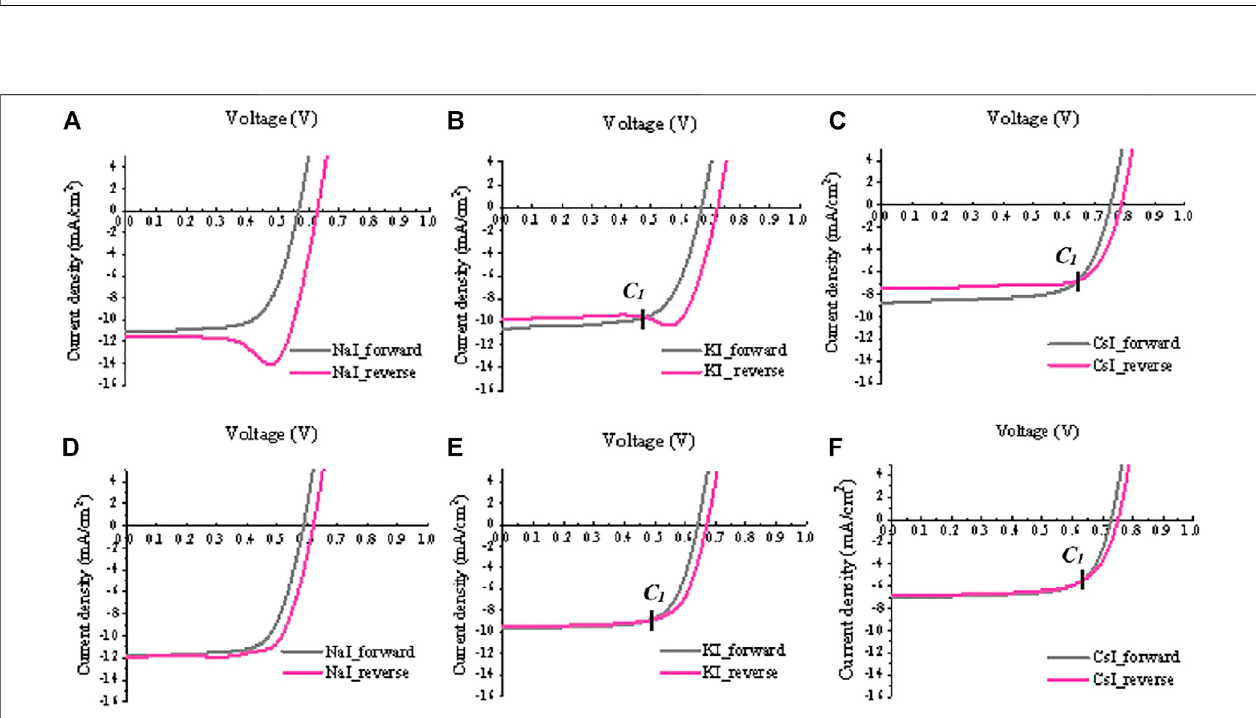
Frontiers in Energy Research |